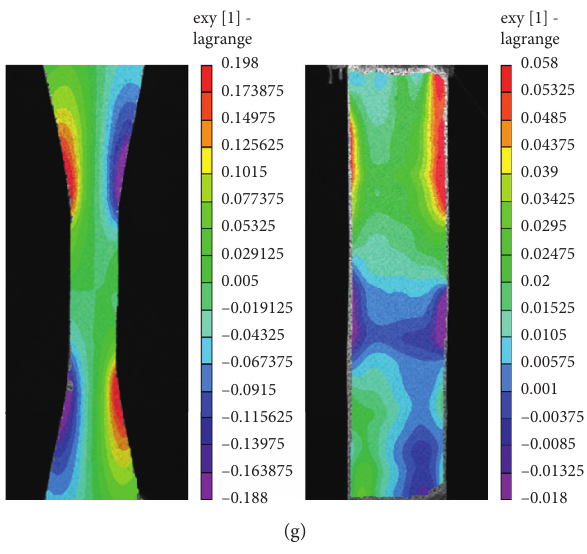
Figure 7: Shear strain field during tensile testing. (a) 0 ° . (b) 15 ° . (c) 30 ° . (d) 45 ° . (e) 60 ° . (f) 75 ° . (g) 90 °